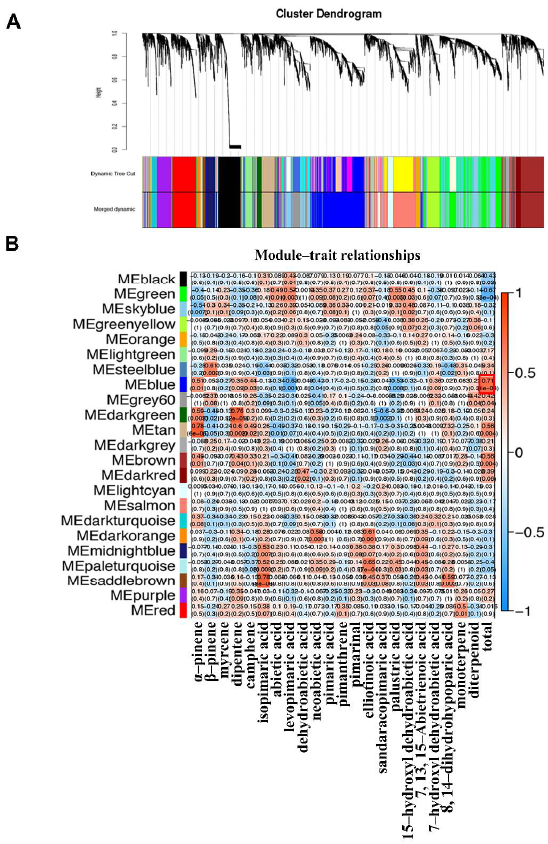
Figure 3. WGCNA analysis of the transcripts associated with the biosynthetic and metabolic processes of pine oleoresin. ( A ) The hierarchical cluster tree of 30,330 unigenes. ( B ) The analysis of module–trait correlations, with rows representing the modules while columns representing the specific chemical compounds. The intersections of rows and columns are color-coded to represent the correlations based on the color legend.